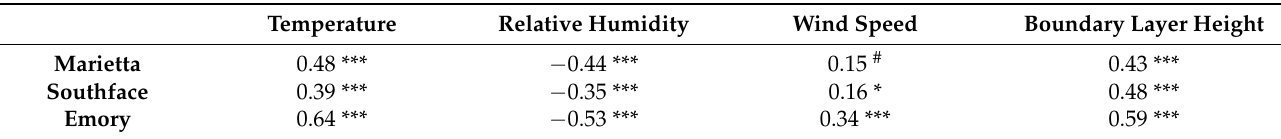
Table A1. Pearson correlation coefficients of hourly pollen counts and meteorology factors at each